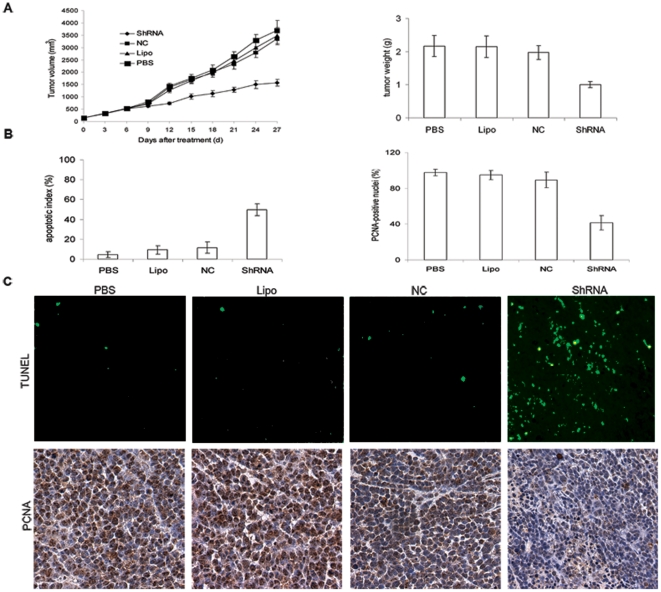
Suppression of PKM2 showed antitumor effects in xenograft mice model.(A). Tumor volume growth curve and tumor weight after caudal vein injection of PKM2-ShRNA plasmids complexed with cationic liposome (DOTAP/Chol). PKM2-ShRNA treatment resulted in significantly decreased tumor growth, compared with control groups (P<0.05). (B & C). TUNEL assay and PCNA IHC staining showed the average percentage of PCNA- and TUNEL-positive-staining nuclei (counted in five random fields) were significantly lower (PCNA assay) or higher (TUNEL assay) compaired with control groups (P<0.01).